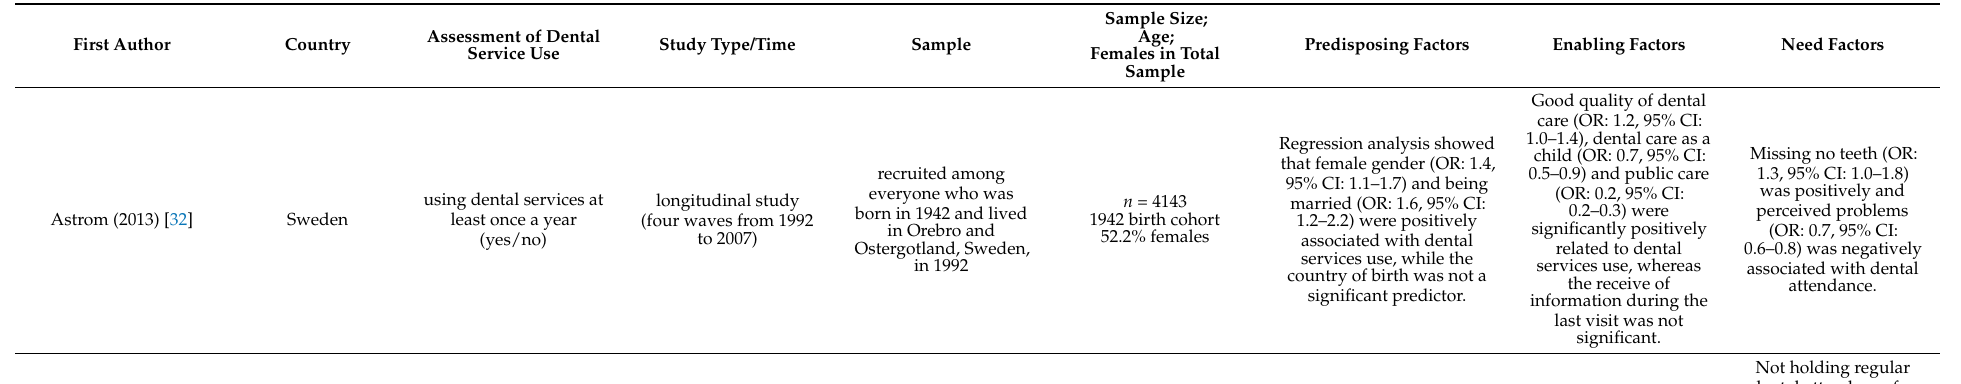
Table 3. Study overview and main findings